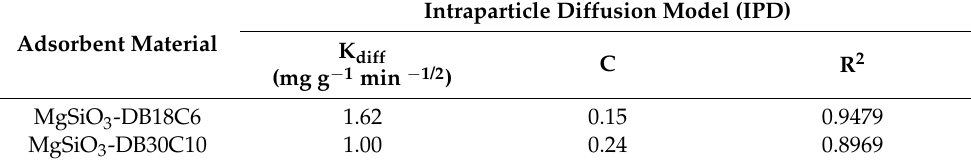
Table 3. The intraparticle diffusion model (IPD) parameters for Pd(II) adsorption onto adsor- bent materials.